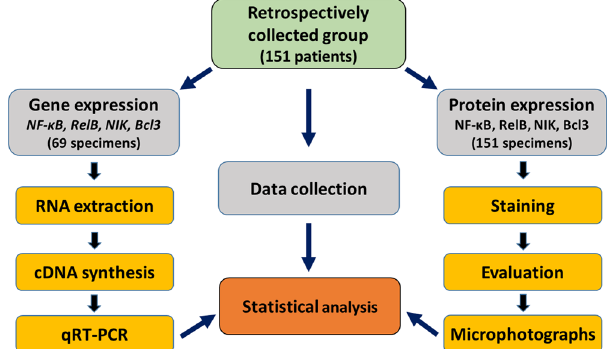
Figure 7. Overview of the workflow of the current study. Abbreviations: qRT-PCR, quantitative Reverse Transcription